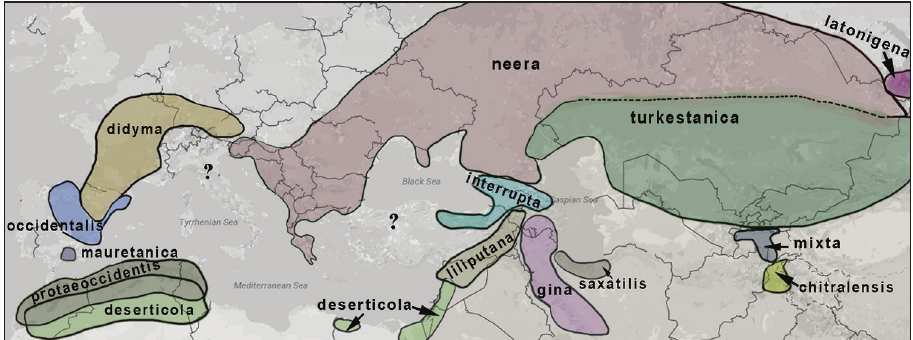
Figure 7. Distribution ranges of western COI haplogroups of Melitaea didyma complex.